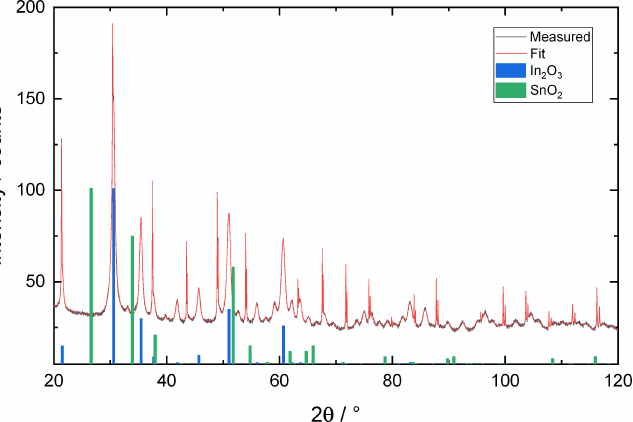
Figure 3. Indium tin oxide (ITO) powder, X-ray diffractogram showing measured (black) and fit data (red). The main peaks for constituent oxides SnO 2 (green) and In 2 O 3 (blue) are included for